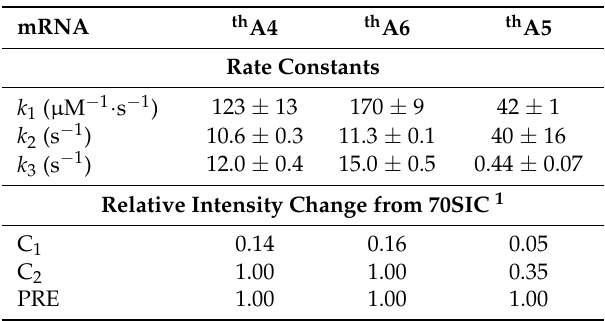
Table 2. Microscopic rate constants fit to Scheme 1 and relative th A fluorescence intensity changes.